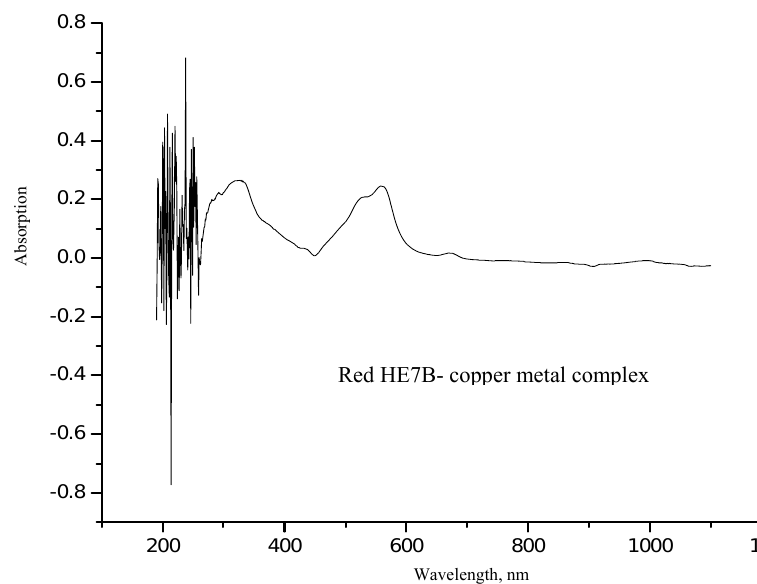
Figure 4. Absorption spectra of azo dyes and azo-copper metal